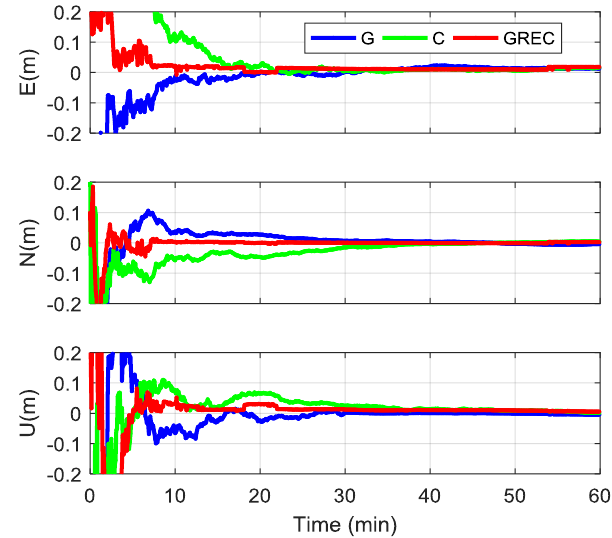
Figure 6. Static PPP AR solutions of GPS, BDS, and multi-GNSS (GREC) at station ASCG from 19:00 to 20:00 on January 1, 2017.